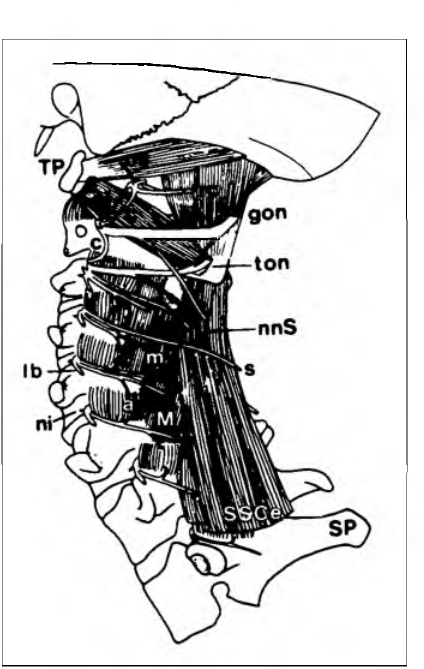
Fig 3: Deep dissection of the left cervical dorsal rami. The superficial posterior neck muscles have been resected. The lateral branches (lb) of the dorsal rami and the nerves to the intertransversarii (ni) have been transected, leaving only the medial branches (m) intact. The Cl dorsal ramus supplies the obliquus superior (os), obliquus inferior (oi) and rectus capitis (re) muscles. The medial branches of the C2 and C3 dorsal rami, respectively, form the greater occipital (gon) and third occipital (Ion)